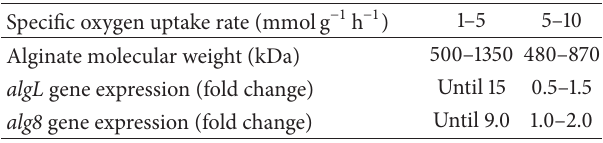
Table 2: Molecular weight of alginate and relative gene expression of alg8 and algL with respect to the 𝑞 O 2